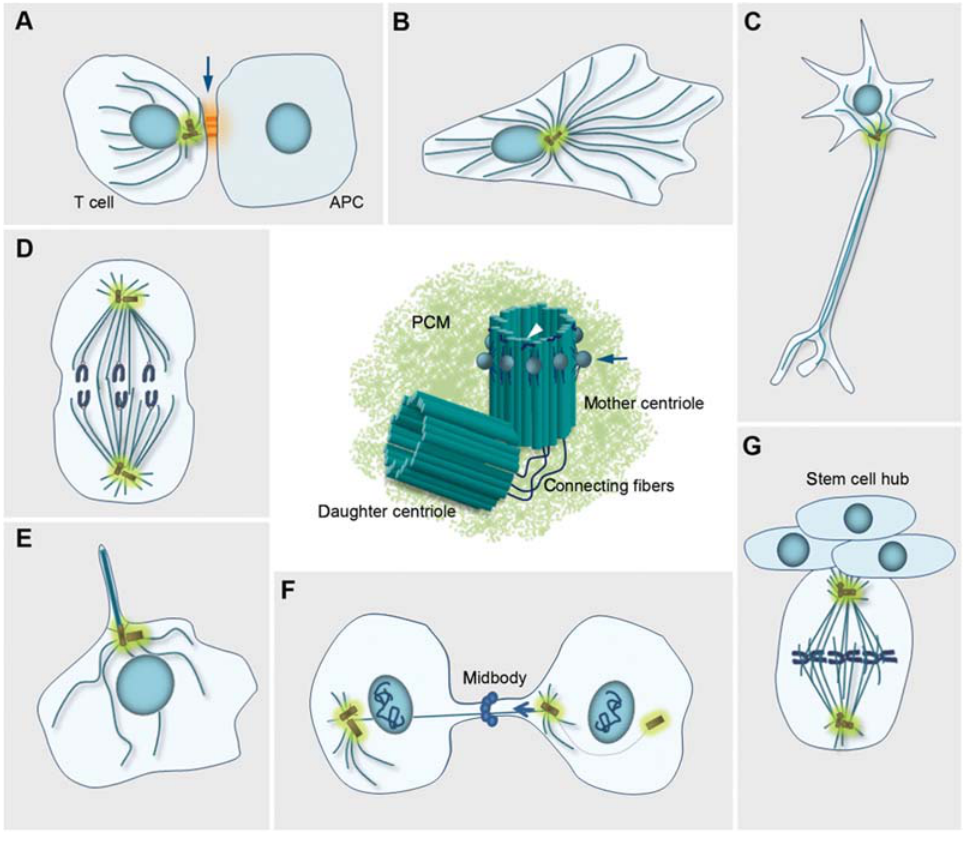
Figure 1 The centrosome as a key player in cell biology. At the center is a schematic representation of the centrosome where the two centrioles, connected by the connecting fibers and surrounded by the pericentriolar material (PCM), are visible. The mother centriole presents distal (arrow) and subdistal (arrowhead) appendages and is more robust in microtubule anchoring. The centrosome and its positioning have been shown to be involved in several cellular and develop- mental processes, such as: (A) immune synapse establishment, (B) cell migration, (C) axon growth site specification, (D) mitotic spindle organization, (E) ciliogenesis, (F) cytokinesis, and (G) asymmetric cell division. For detailed explanations see the text.